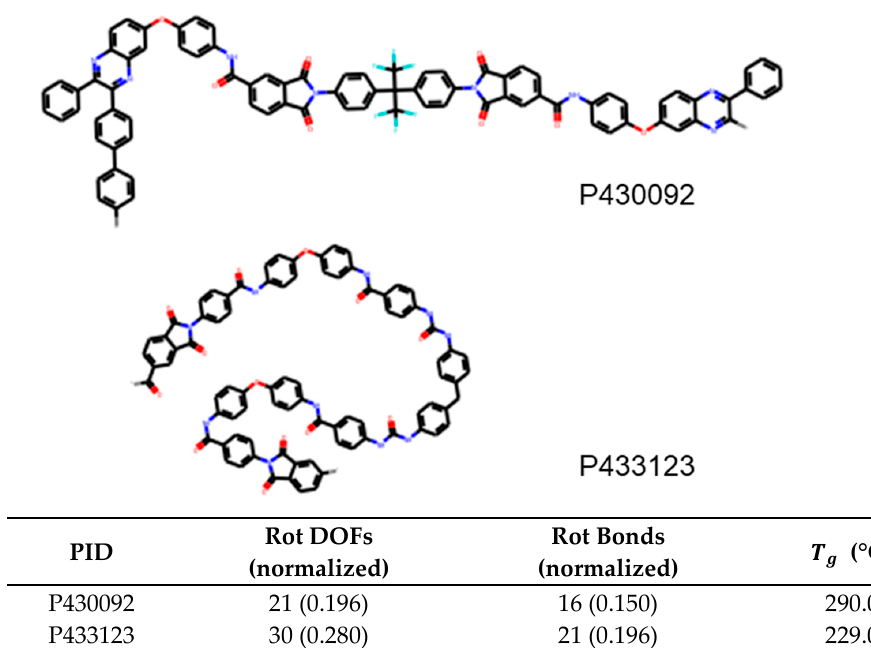
Figure 8. Example of two polyamides, with IDs P430092 and P433123, for which the number of rotatable bonds can be used to predict the trend of T g accurately. importance of 0.44, a correlation weaker than what was found for (cid:1846) (cid:3034) , nonetheless fairly significant. The melting temperature is found to decrease with increasing rotational DOFs.